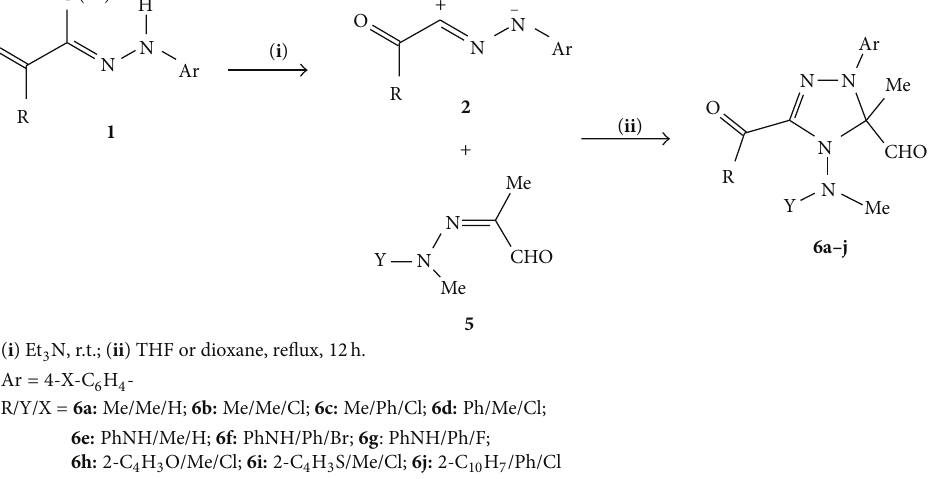
Scheme 2: Synthetic pathway for the preparation of triazoles 6a – j